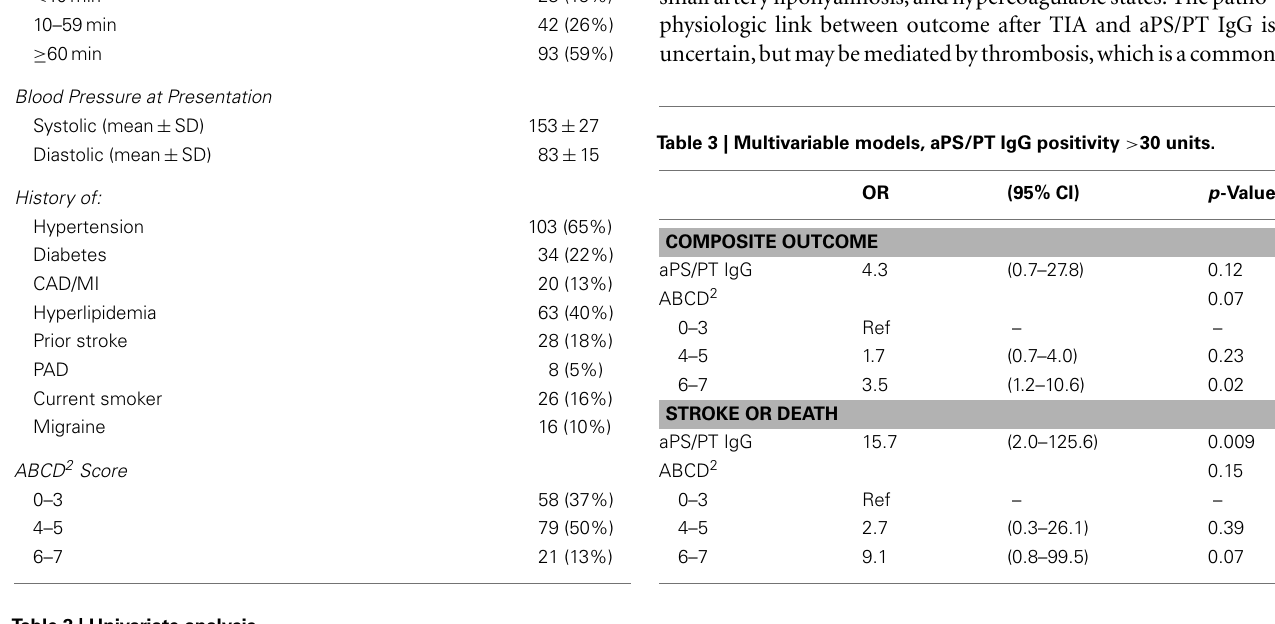
Table 2 | Univariate